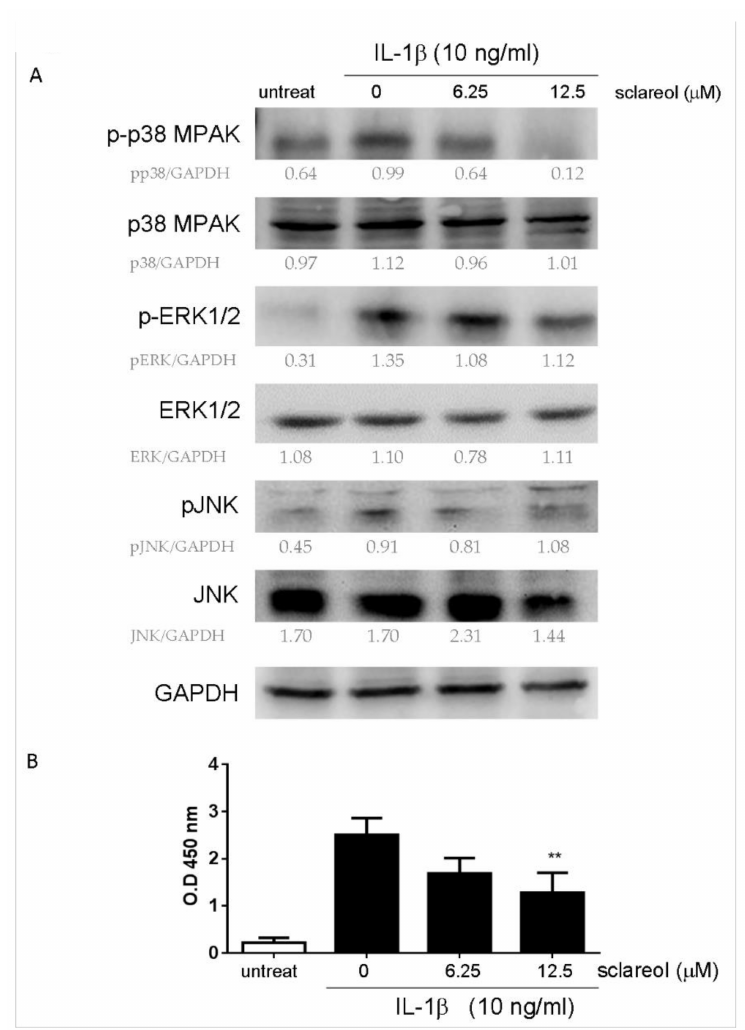
Figure 7. Effect of sclareol on MAPK and NF- κ B pathways in IL-1 β -stimulated SW982 cells. SW982 cells were stimulated with 10 ng/mL of IL-1 β with or without sclareol and lysed after 24 h. ( A ) Expressions of c-Jun N-terminal kinase (JNK), ERK, and p38-MAPK (native and phosphorylated) in whole cell lysates were determined by Western blot with the indicated antibodies. GAPDH was used as a loading control. ( B ) The translocational activities of NF- κ B with or without sclareol were determined by NF- κ B activation and presented as optical density (OD) values at a wavelength of 450 nm. Bar graphs represent the mean ± SD of triplicate tests. ** p < 0.01 versus vehicle-treated DMSO group. The data are representative of three independent experiments with similar